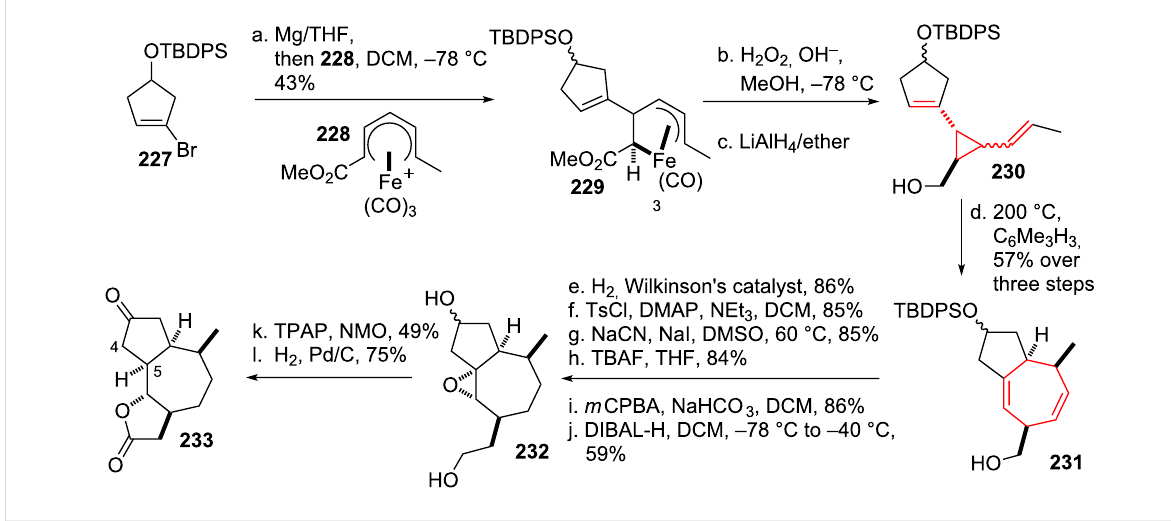
Scheme 27: Donaldson’s organoiron route towards the guianolide skeleton.